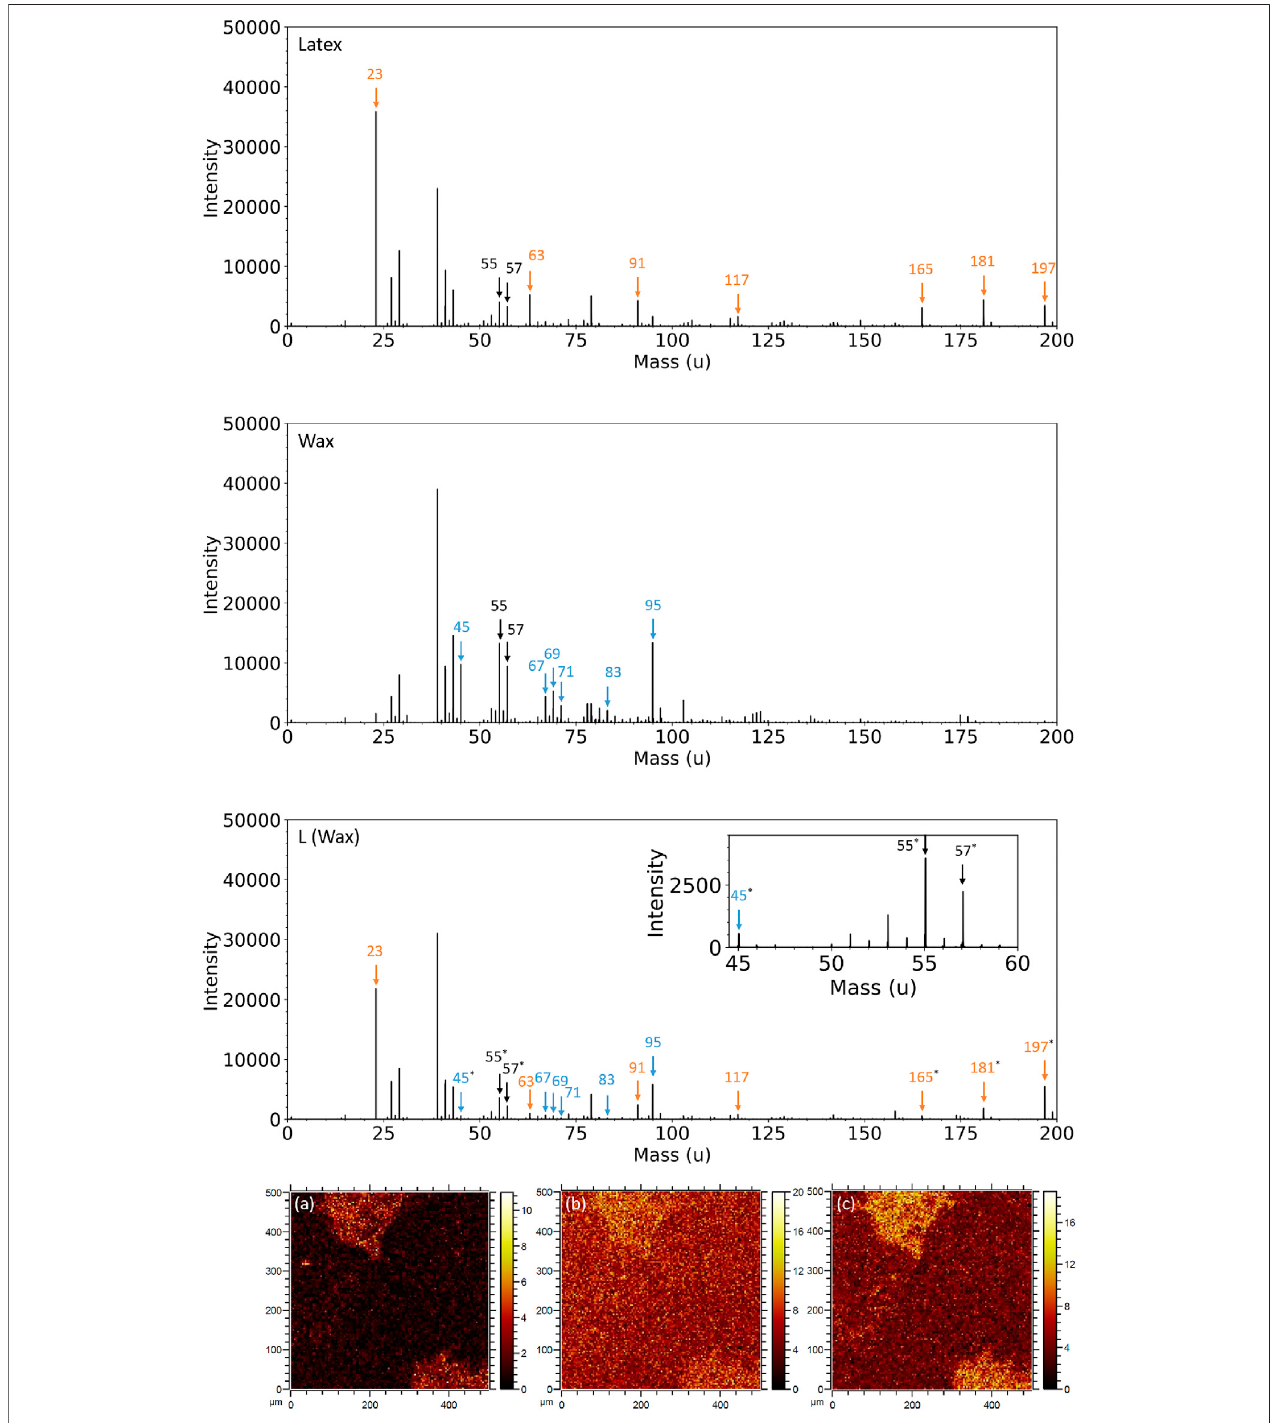
FIGURE9| Positive ionmassspectra intherange0 – 200 uforLatex (top row),as-receivedwax(second row),and L(Wax)(thirdrow).Blackarrows indicate peaks clearly present in both Latex and wax fi ngerprints, orange arrows represent peaks present in the latex fi ngerprint, blue arrows represent peaks speci fi c to the wax and * represents peaks from which SIMS images have been created. Positive ToF-SIMS images of L (Wax) are shown at (A) 45 u (C 2 H 5 O + ), (B) 55 u (C 4 H + 7 /C 3 H 3 O + ), and (C) 57 u (C 4 H + 7 /C 3 H 5 O +